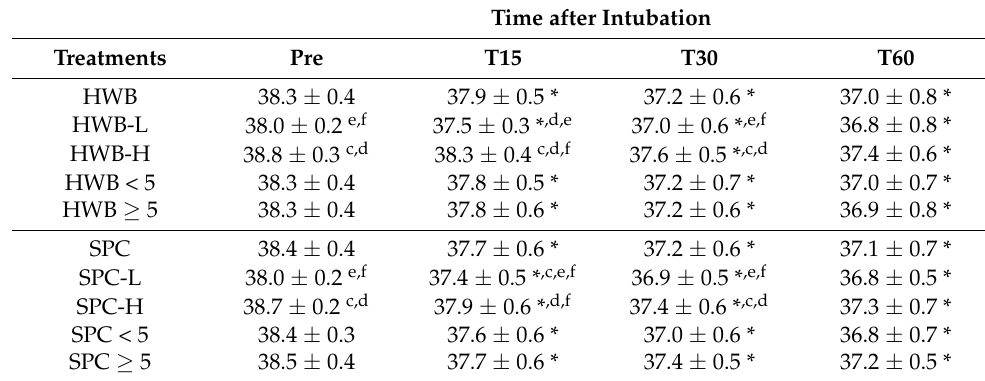
Table 3. Rectal temperature in each group and